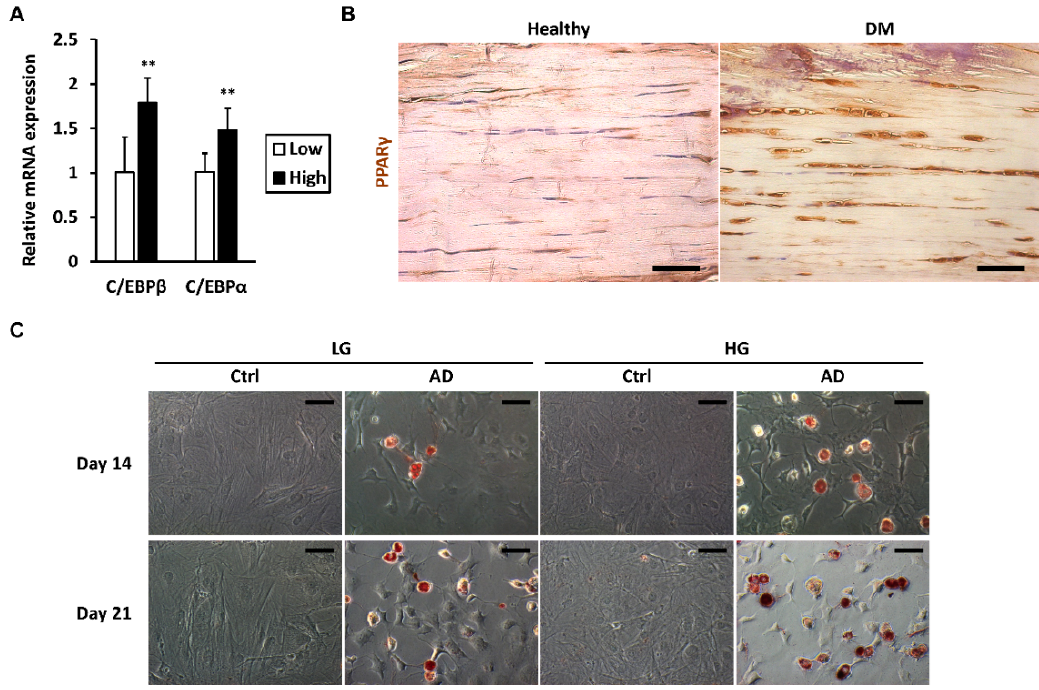
Figure 2. High glucose increases the adipogenic transdifferentiation potential of tenocytes. ( A ) The mRNA expression levels of the adipocyte markers C/EBP β and C/EBP α were measured after tenocytes were cultured in high-glucose (HG) or low-glucose (LG) conditions for 1 week. Data are presented as the mean ± SD ( n = 6). Statistical significance is shown as ** p <0.01 compared to the low-glucose control group; ( B ) Tendons from STZ-induced type 1 diabetes mellitus (DM) mice (duration >1 year) were analyzed by immunohistochemistry for PPAR γ . Healthy: age-matched control mice without DM. Scale bar = 50 μ m; ( C ) After pre-culturing in different glucose concentrations for 1 week, tenocytes were stimulated by adipogenic differentiation medium. Adipogenesis was examined using Oil Red O staining two and 3 weeks later. AD: adipogenic differentiation medium. Ctrl: culture medium. Scale bar = 50 μ m.